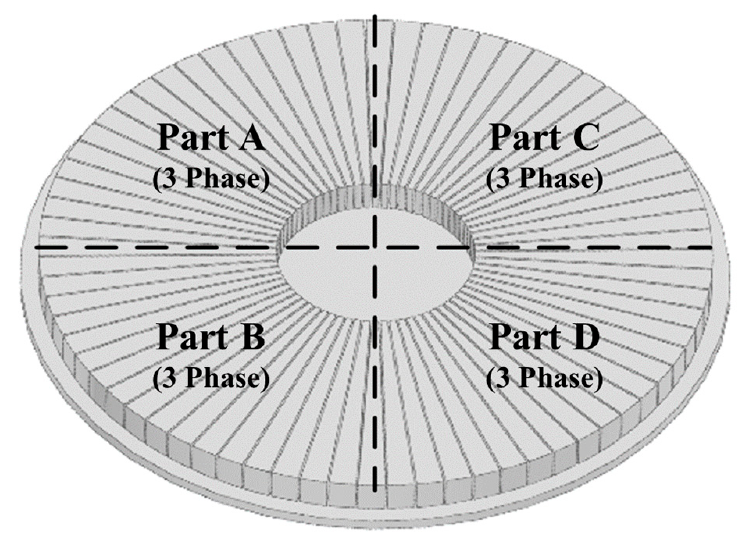
Figure 2. Stator divided into 4 parts (A–D).